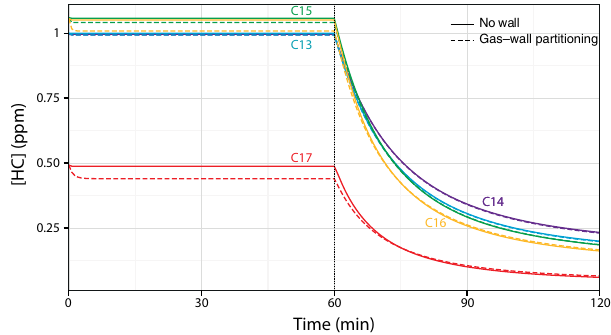
Figure 5. Simulated temporal evolutions of the decays of n-alkanes in the gas phase without (solid line) and with (dashed line) gas– wall partitioning. The dotted line at 60min corresponds to the time at which the lights are turned